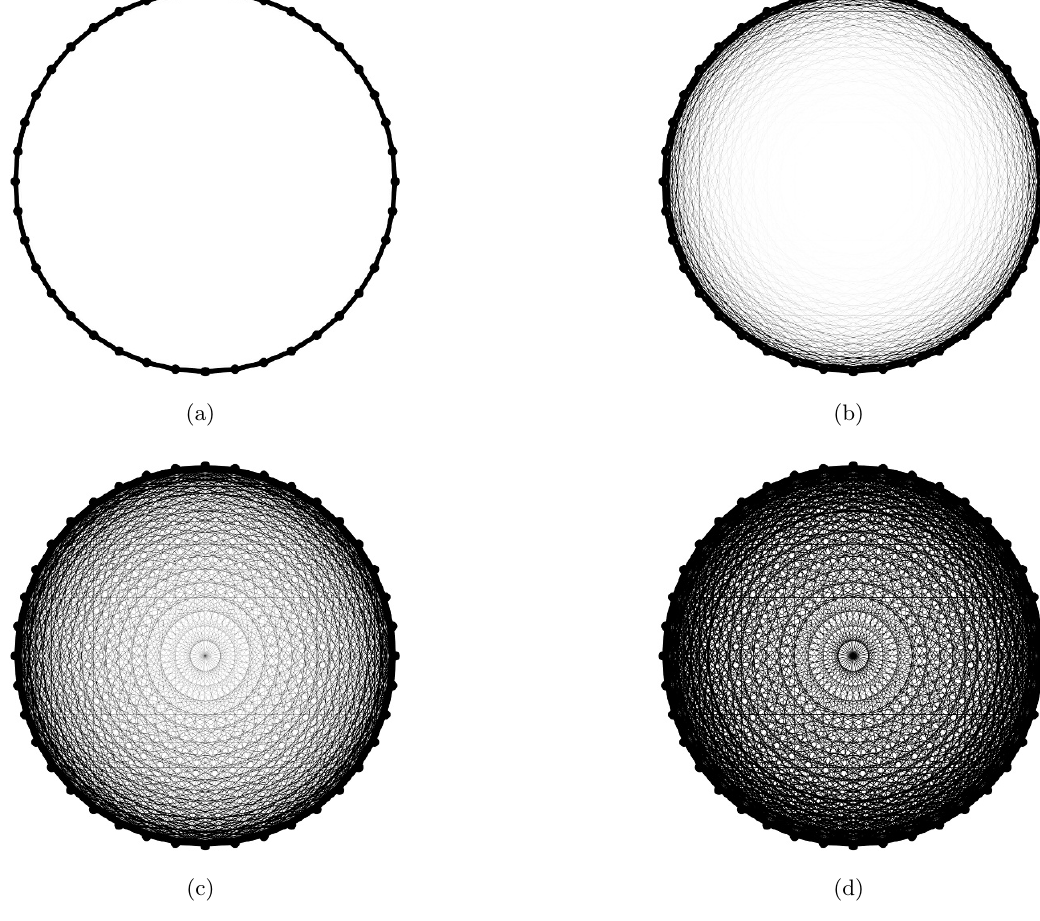
Figure 6 . Snapshots of the graphs that arise from the numerical solution of T ij ( t ) at (a) t = 0, (b) t = 15, (c) t = 30, (d) t = 45 for (cid:15) = 0 : 12 with R = U = (cid:21) = 1 and L = 40. Dots represent sites, and the thickness of the line between sites i and j is proportional to j T ij j